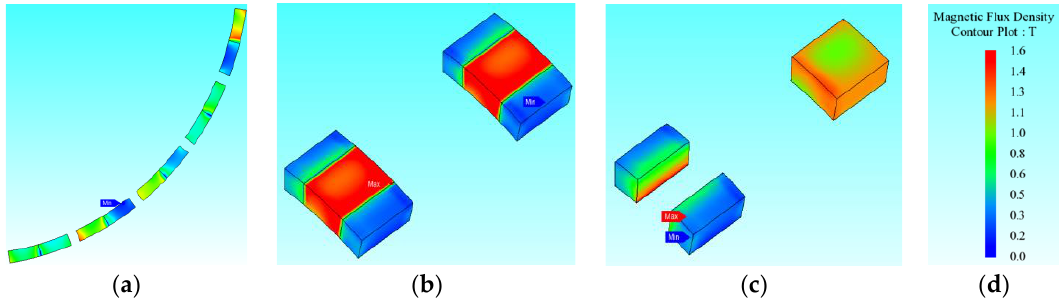
Figure 11. Magnetic density distribution of the permanent magnet in the motor during three-times overload. ( a ) FRM, ( b ) TF-FRM, ( c ) TF-CFRM, and ( d ) reference ruler. overload. ( a ) FRM, ( b ) TF-FRM, ( c ) TF-CFRM, and ( d ) reference